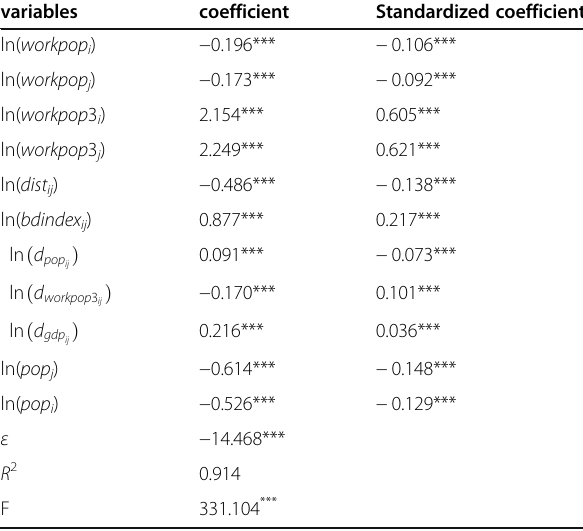
Table 4 Results of